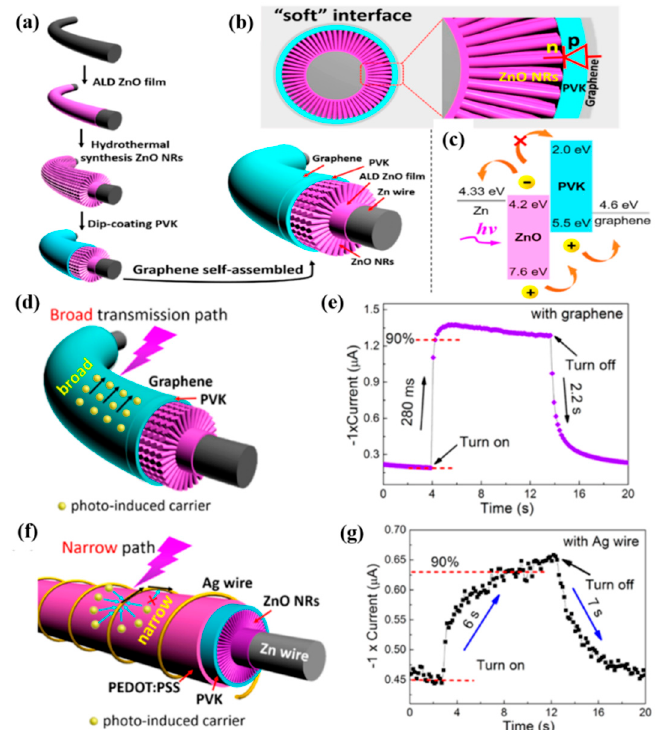
Figure 9. ( a ) Schematic diagram of the preparation process procedure of hybrid fiber-shaped photodetector based on ZnO NRs array/PVK/graphene. ( b ) The cross-sectional diagram of the device that revealed the p–n heterojunction and all tight soft interfaces in the PDs. ( c ) Schematic diagram of the corresponding energy levels of the material involved in the PD device, as well as the transportation of electrons and holes caused by the arrangement of interfacial energy levels. ( d ) Schematic representation of the transport property of the photoinduced carriers in the PD with structure of ZnO/PVK/graphene. Photoresponse characteristics of ( e ) corresponding current–time curves of ZnO/PVK/graphene PDs. ( f ) Schematic representation of the transport property of the photoinduced carriers in the PD with structure along Ag wire. ( g ) Corresponding current–time curves [105] .